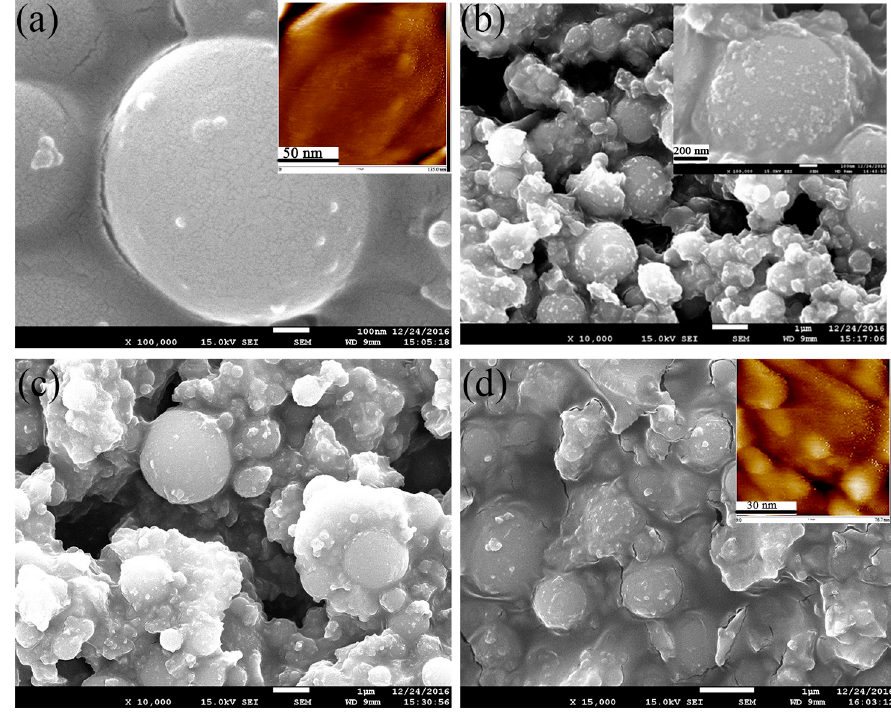
Figure 6. Scanning electron microscope (SEM) and atomic force microscope (AFM) images of ( a ) SiO 2 microsphere and ( b – d ) SiO 2 –TiO 2 with different ratios. ( b ) 30% TiO 2 , and the inset image is a high magnification image; ( c ) 40% TiO 2 ; and ( d ) 50% TiO 2 ; the inset images in ( a , d ) are AFM images.